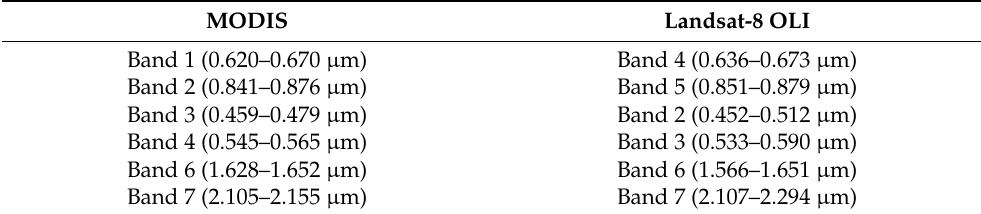
Table 2. Equivalence of MODIS and Landsat-8 OLI spectral bands. MODIS Landsat-8